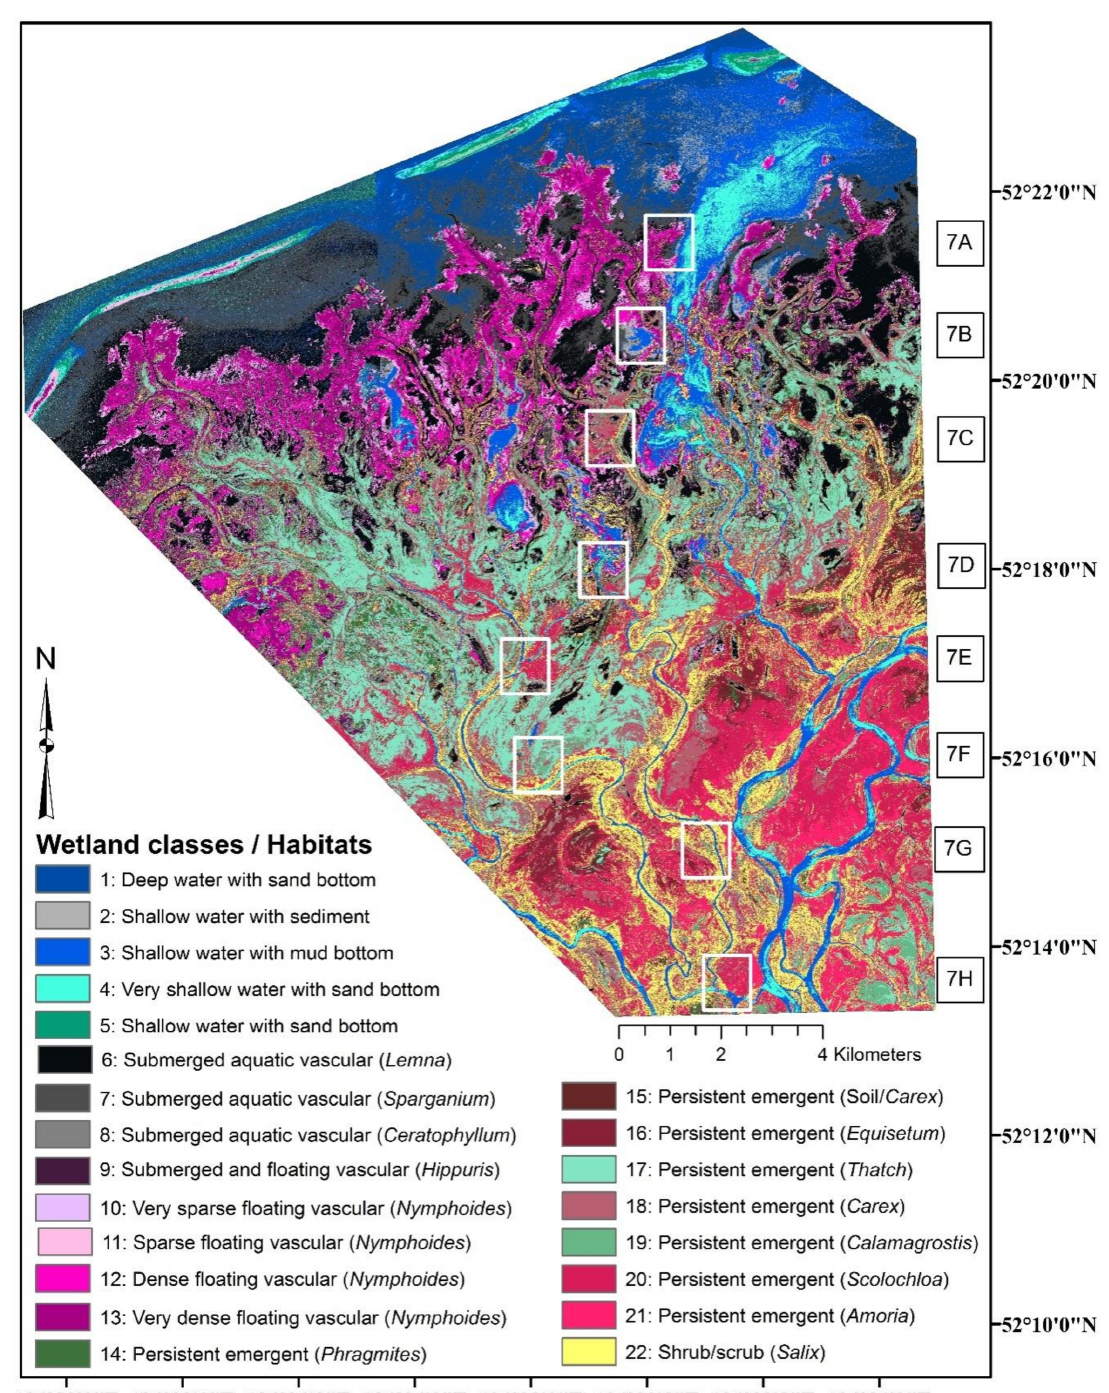
Figure 6. The RF-classified study area. Classes in the legend were attributed based on wetland plant abundance, water depth, and substrate composition (see, e.g., [60]). The north-to-south, wetter-to-drier boxes in Figure 6 are further discussed in Figure